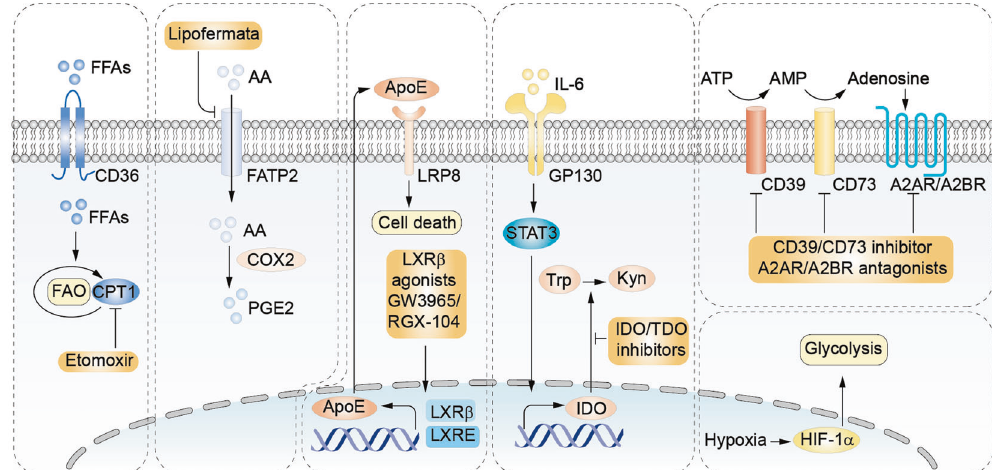
Fig. 5 Targeting MDSCs by interrupting their metabolism. MDSCs are characterized by high free fatty acids (FFAs) uptake and fatty acid oxidation (FAO). Carnitine palmitoyltransferase 1 (CPT1), the fi rst rate-limiting enzyme in the FAO cycle, can be inhibited by etomoxir. FATP2 mediates the uptake of arachidonic acid (AA) which subsequently promotes the synthesis of PGE2 in MDSCs. Lipofermata selectively inhibits FATP2. LXR agonists promote the transcriptional upregulation of apolipoprotein E (ApoE) which subsequently reduces MDSCs survival by binding to low-density lipoprotein receptor-related protein 8 (LRP8) on MDSCs. IDO and tryptophan 2,3-dioxygenase (TDO) catalyze the fi rst rate-limiting step in the conversion of L-tryptophan to L-kynurenine. IL-6 upregulates the transcription of IDO promoter in MDSCs through STAT-3 activation. IDO/TDO inhibitors attenuate the suppressive capability of MDSCs. Adenosine-generating axis and its receptor A2AR/A2BR are also metabolic targets to inhibit MDSCs. MDSCs exhibit upregulated glycolysis which is regulated by HIF-1 α . CD36, fatty acid translocase; FATP2, fatty acid transport protein 2; LXR, Liver-X receptors; Trp, tryptophan; Kyn,